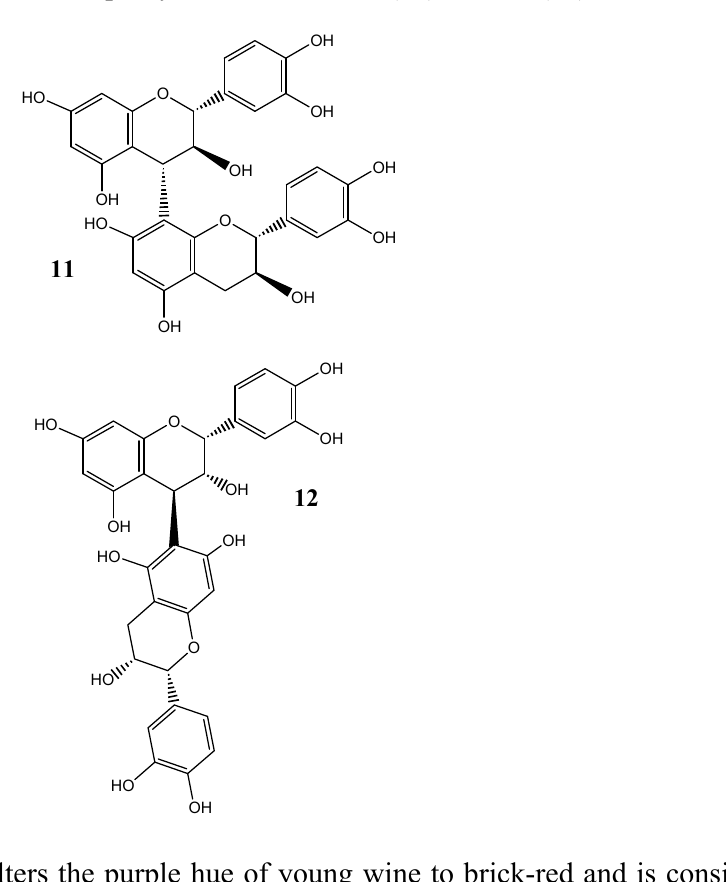
Figure 3. Structures of procyanidin dimers B3 ( 11 ) and B5 ( 12